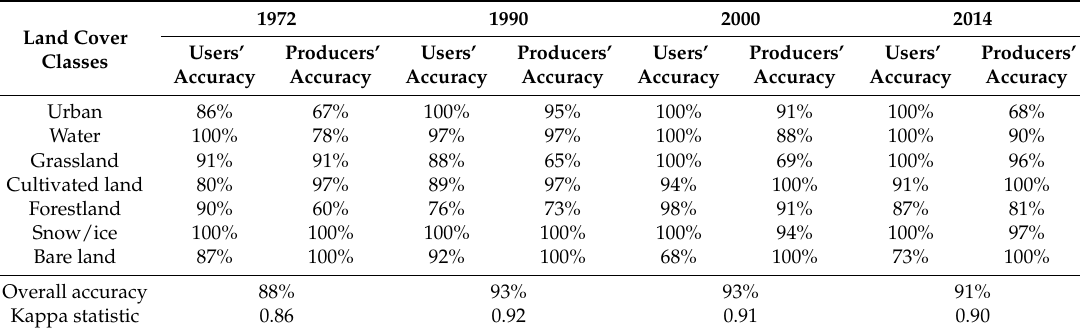
Table 3. Accuracy assessment of land cover (LC) map for 1972, 1990, 2000, and 2014.